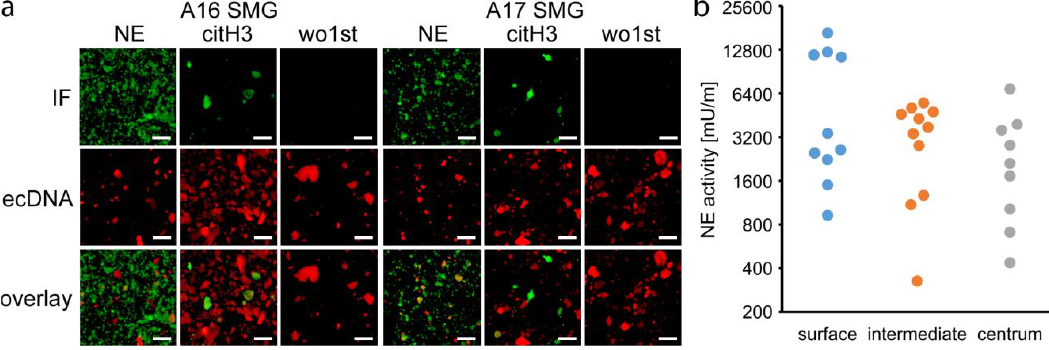
Figure 4. Sialoliths contain extracellular DNA, neutrophil elastase, and citrullinated histone H3. ( a ) Representative staining of neutrophil elastase (NE), citrullinated histone H3 (citH3), and extracellular DNA (ecDNA) in gravel of submandibular sialoliths (SMG: submandibular gland sialolith; IF: immunofluorescence; wo1st: without first antibody, negative control, n = 5). The co-localization of these molecules (overlay) indicate neutrophil extracellular traps (NETs) as building blocks of the sialoliths. ( b ) Neutrophil elastase activity was present in all parts of the sialoliths (quantified with a specific fluorogenic substrate, n = 11). The highest activities were detected in the superficial layers. Scale bar: 200 µm.